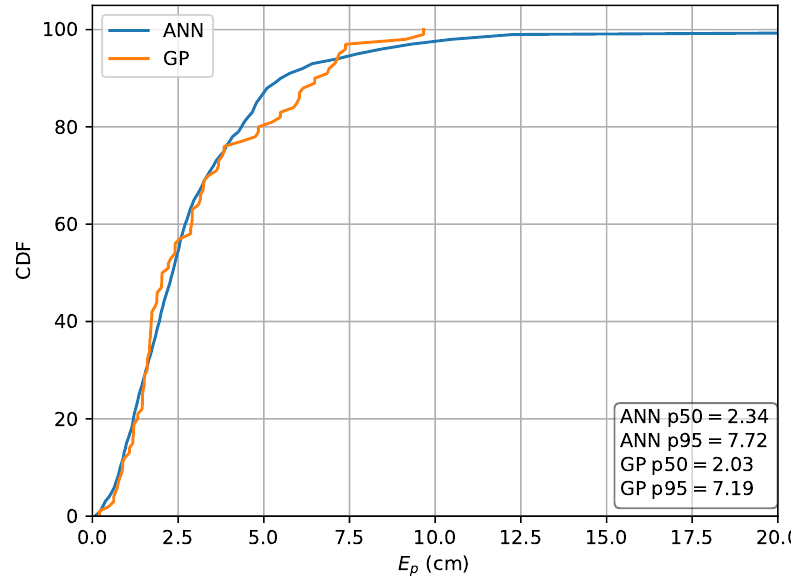
Figure 11. Cumulative distribution of the error evaluated on set A for the ML methods in the case the relative intensities r rel , max are used as features.